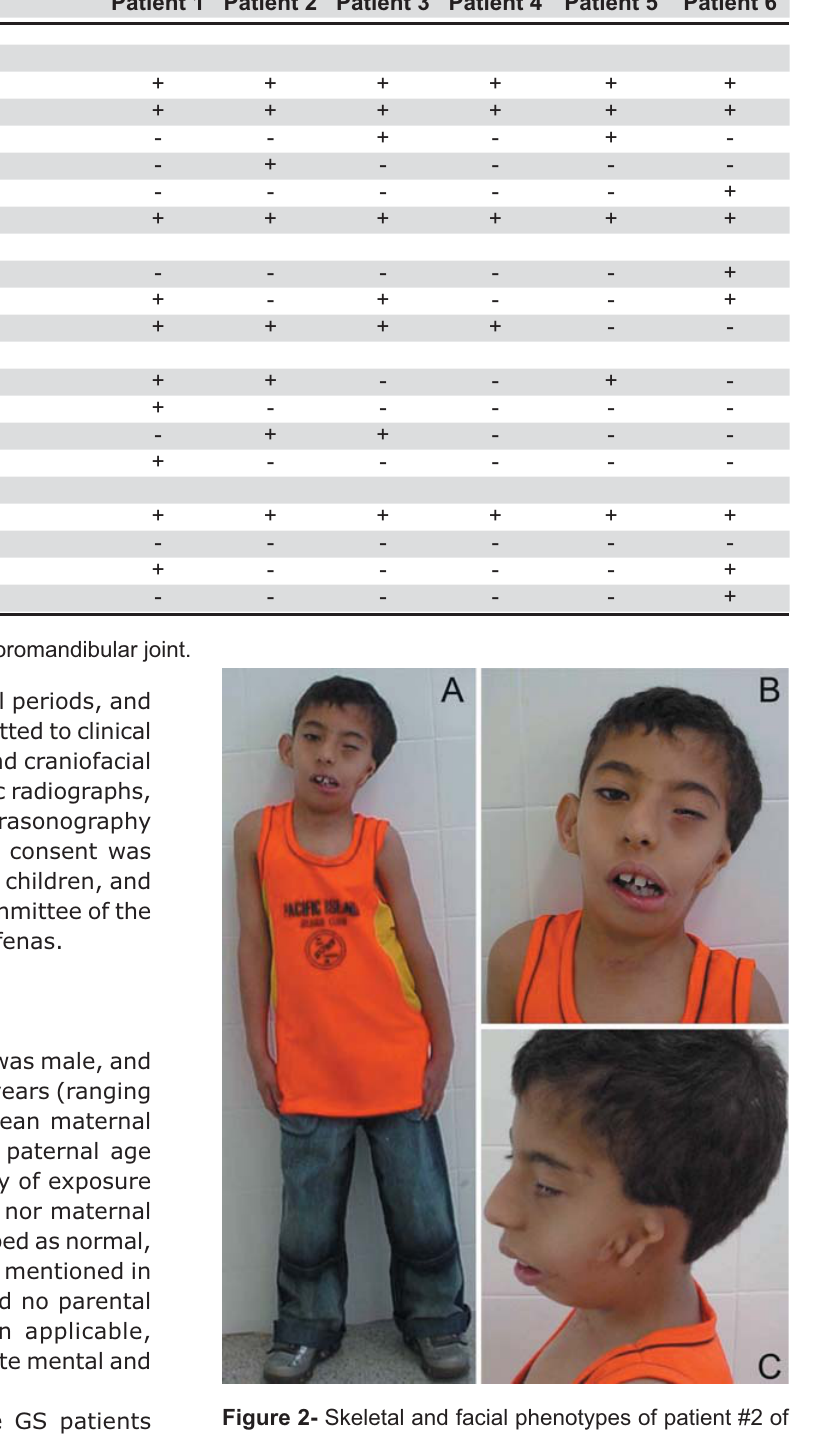
eyelid coloboma of the left eye. (C) Lateral view of